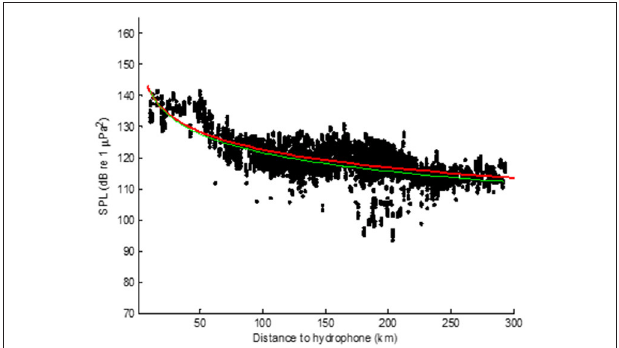
FIGURE 6 | Received level in the third octave band centered on 40 Hz at the Greenland II recorder. The green line represents spherical loss; the red line is a logarithmic fit with optimal parameters − 19 log 10 (R) with residual RMS = 4.2